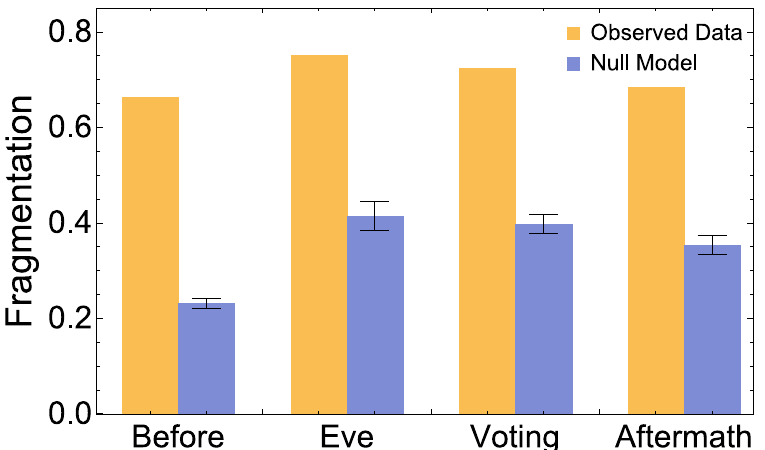
Fig 4. The online system is characterized by social fragmentation. Top : Fragmentation encodes the tendency of online users to organize in multiple opposing groups (see the text for further detail). During the four considered periods, the online social network is fragmented much more than random expectation. Small changes in fragmentation of the observed system across time are reflected in the null model, indicating that they can be explained by small changes in the heterogeneity of the underlying connectivity. Error bars indicate standard